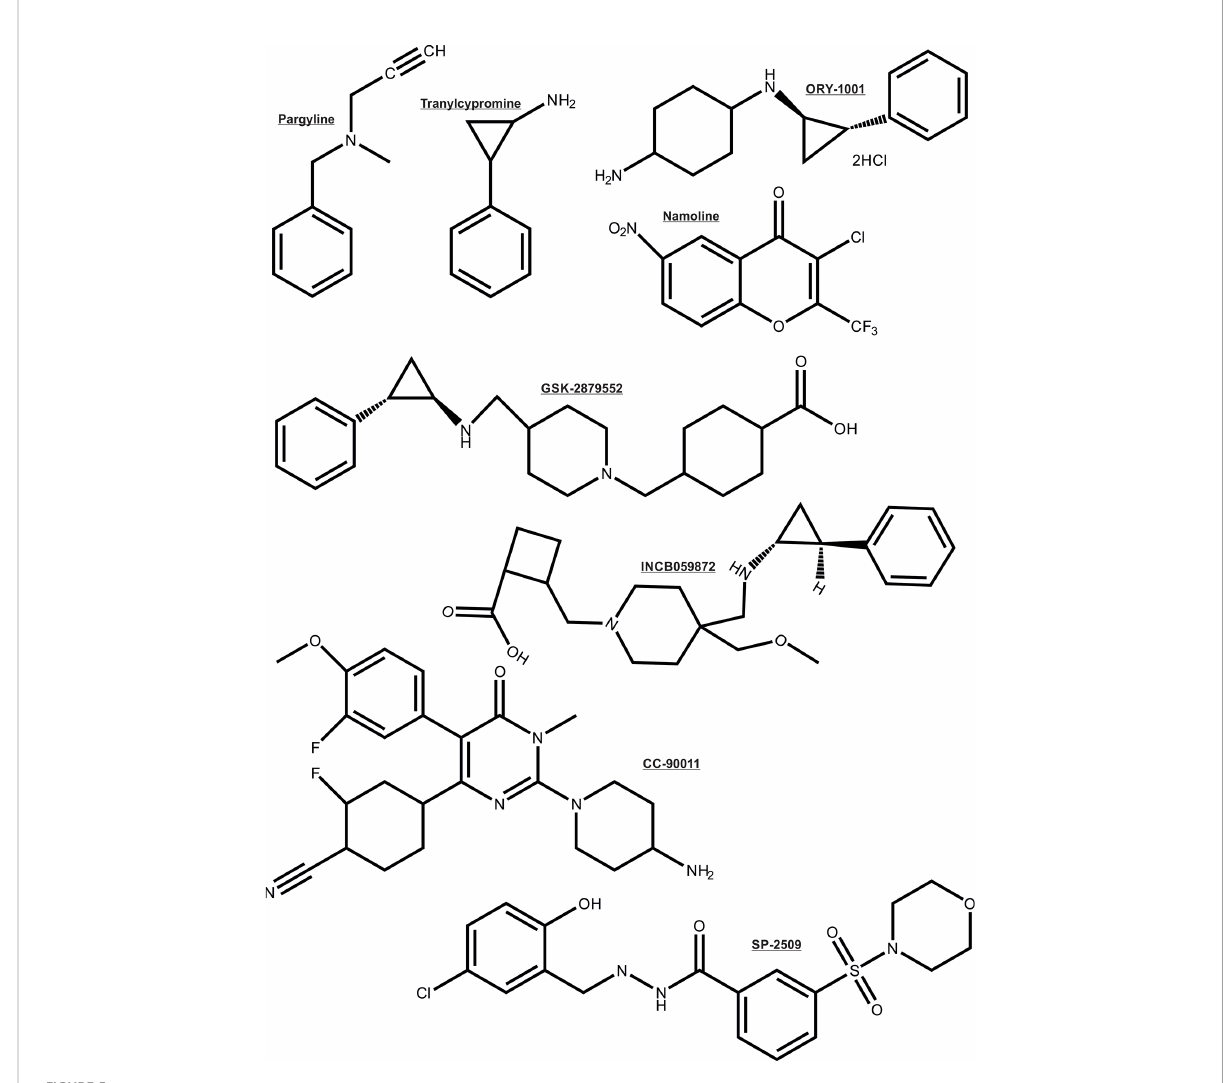
FIGURE 5 Chemical structure of the KDM1A